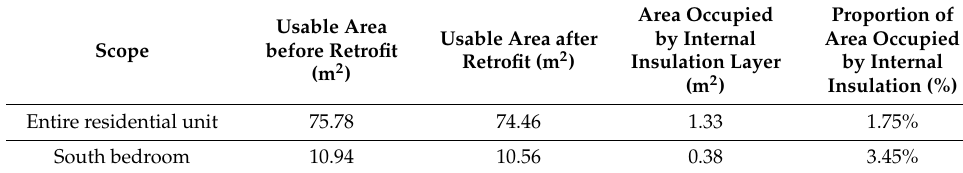
Table 5. The proportion of interior insulation to the usable area of the